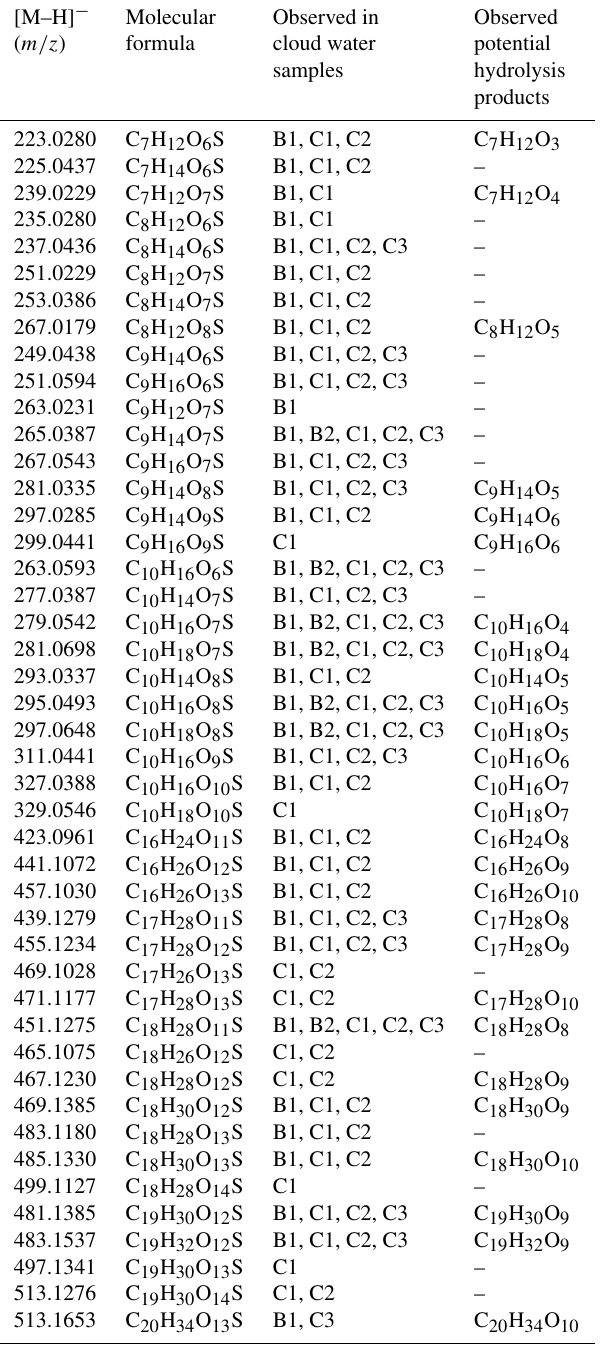
Table 4. Identity of possible organosulfates, previously observed in the laboratory from the evaporation and re-dissolution of an aque- ous solution of d -limonene SOA and sulfuric acid (Nguyen et al., 2012b), in each cloud water sample, with observed potential hydrol- ysis products noted.